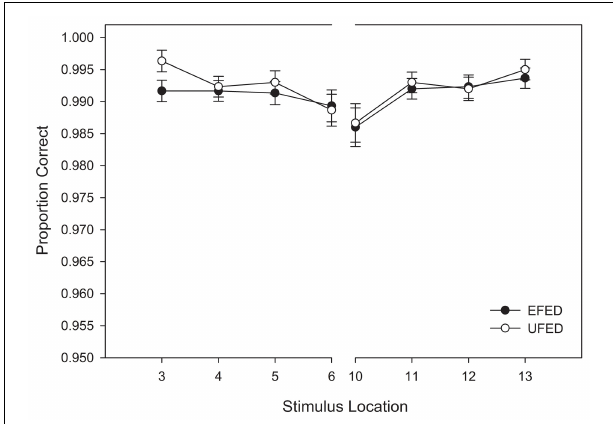
FIGURE 5 | Training categorization response time in equal frequency (EFED) and unequal frequency conditions (UFED). Stimulus values correspond to stimuli selected from the training range (i.e., stimuli 3–13). Error bars represent 1 standard error of the mean ( N =